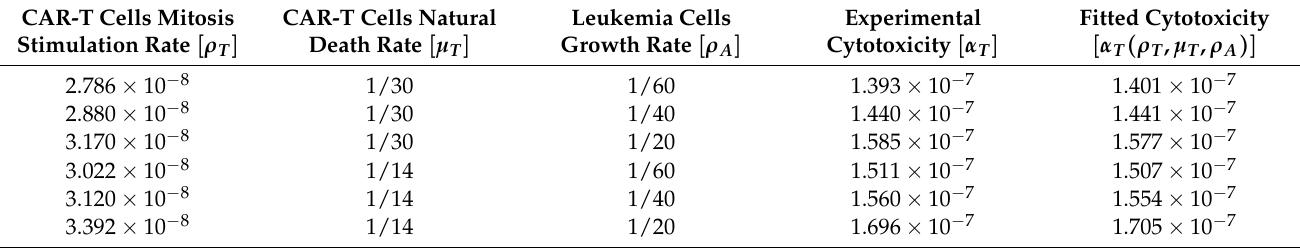
Table 4. CAR-T cells cytotoxicity rates (denoted as α T and given in days − 1 ) estimated by Valle et al. [29] from the Lee et al. [44] phase 1 dose-escalation trial on 21 leukemia